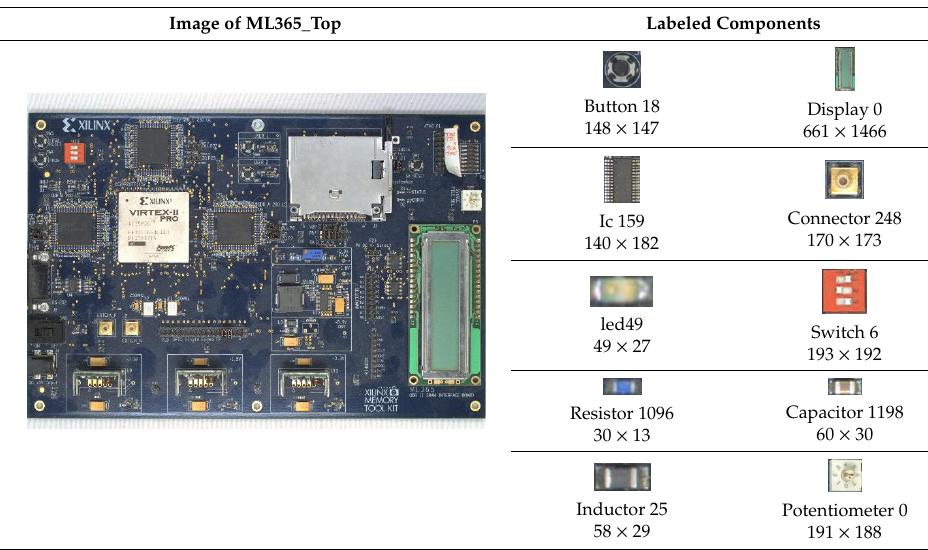
Table 2. Statistical analysis table of PCB-labeled electronic components image size.